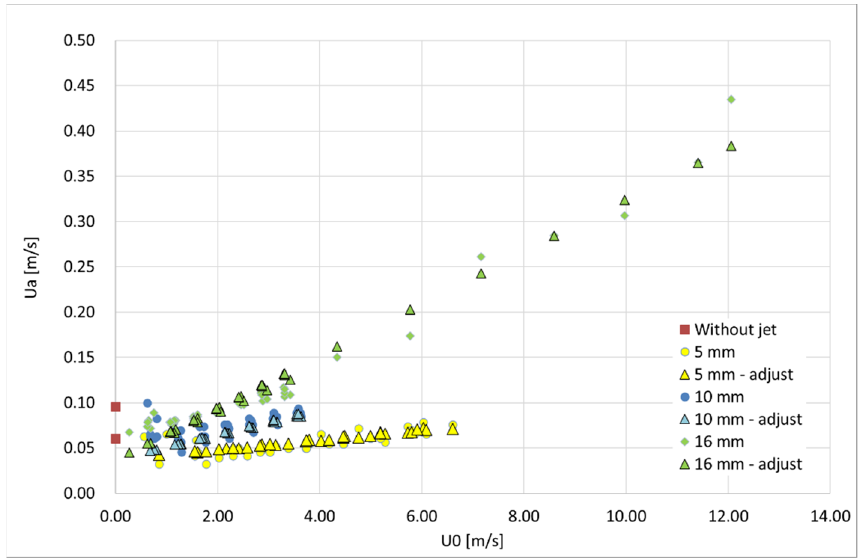
Figure 12. Comparison of the test results with the Equation (3) predictions.